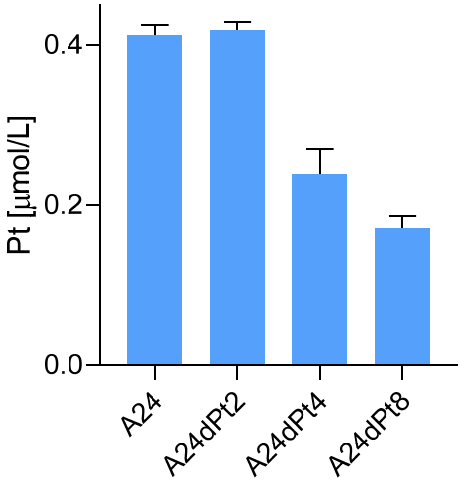
Figure 4. Cellular cisPt concentration in A24, A24dPt2, A24dPt4, and A24dPt8 cells after 16 h incubation with 30 µM cisPt.